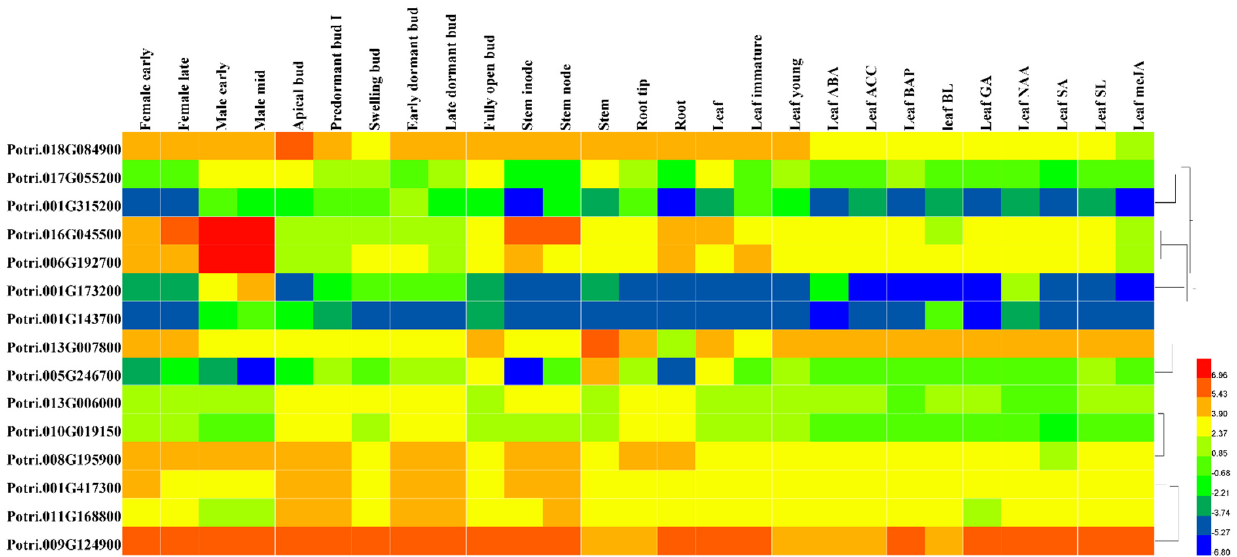
Figure 6. Expression of interaction proteins of PtriZATs encoded genes during different growth stages and stress response. The expression data of 15 PtriZAT genes were from Phytozome13. The sex differentiation samples including early and late growth of female and male plants. The samples of different tissues including bud (apical, predormant, leaf dormant, swelling, early dormant, fully open), leaf (young, immature), root (tip), steam (inode, node). The nine stress treatments include ABA, ACC, BAP, BL, GA, NAA, SA, SL and meJA. The color scale represents the value of Log2(FPKM).